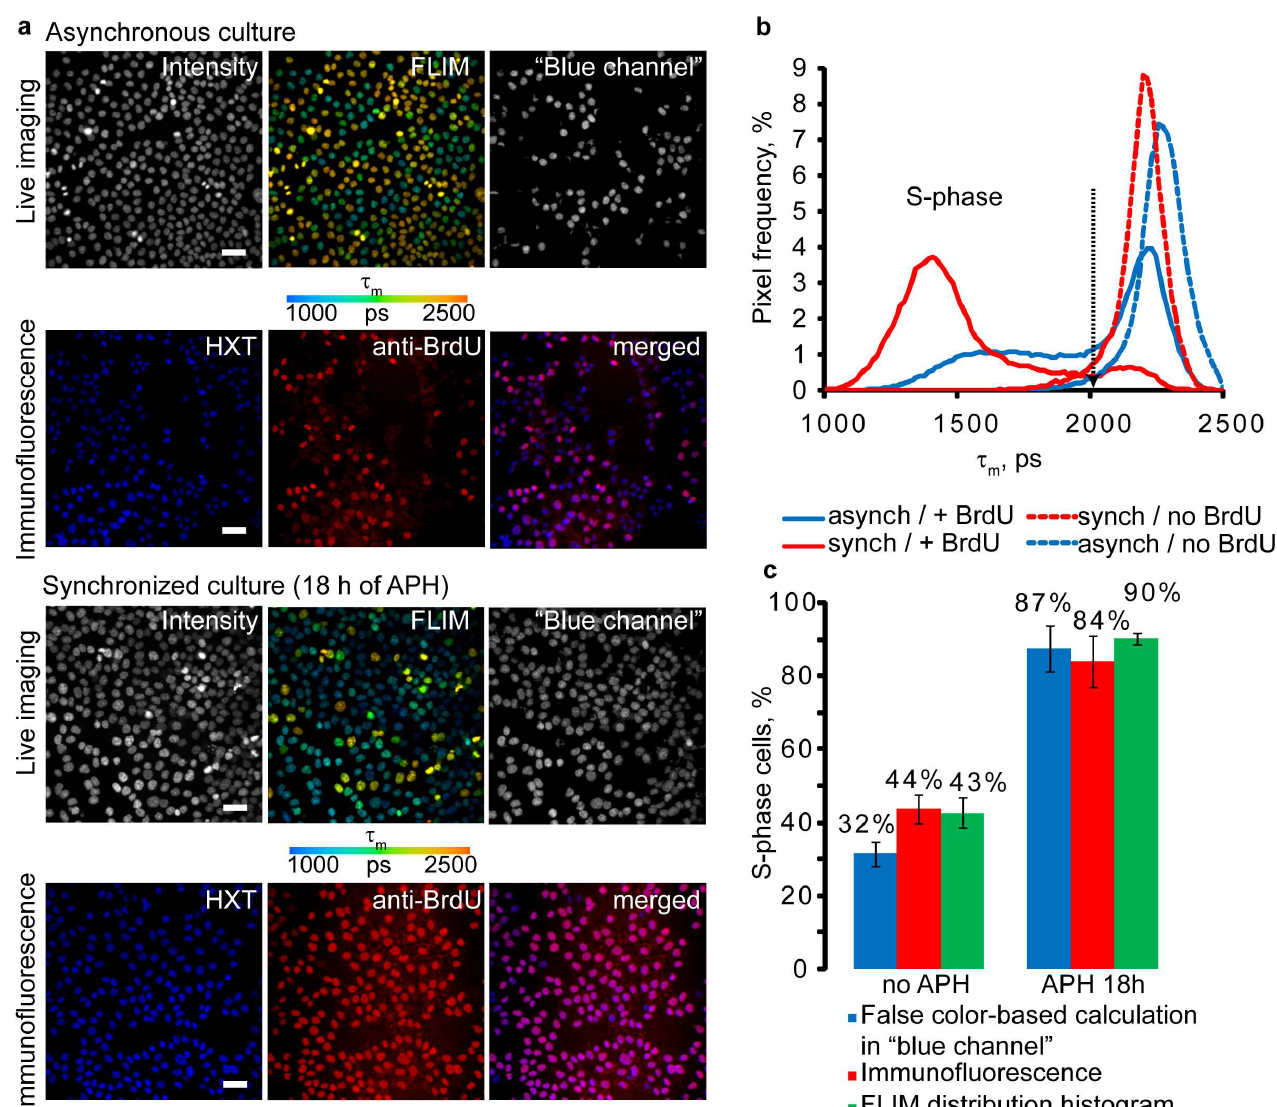
Fig 2. Comparison of FLIM and immunofluorescencemethods of cell proliferation analysis. ( a) Asynchronousand synchronizedlive HCT116cells were incubatedwith BrdU (100 μ M, 4 h) and stained with HXT (1 μ M, 30 min). Immediatelyafter FLIM cells were fixed with 4% paraformaldehyde and stainedwith anti-BrdUantibody. Scale bar is 50 μ m. (b) Average (n = 5) distributionsof τ m . Black arrow indicatesthreshold τ m , which differentiatesbetweenS phase and non S-phase cells. (c) Cell proliferation rates calculatedby the different methods. Bar chart shows fractions of total cell numbers and standarddeviationfor +BrdU cells (S-phase). The mean values were calculatedfrom five different images of the asynchronous and synchronizedcell